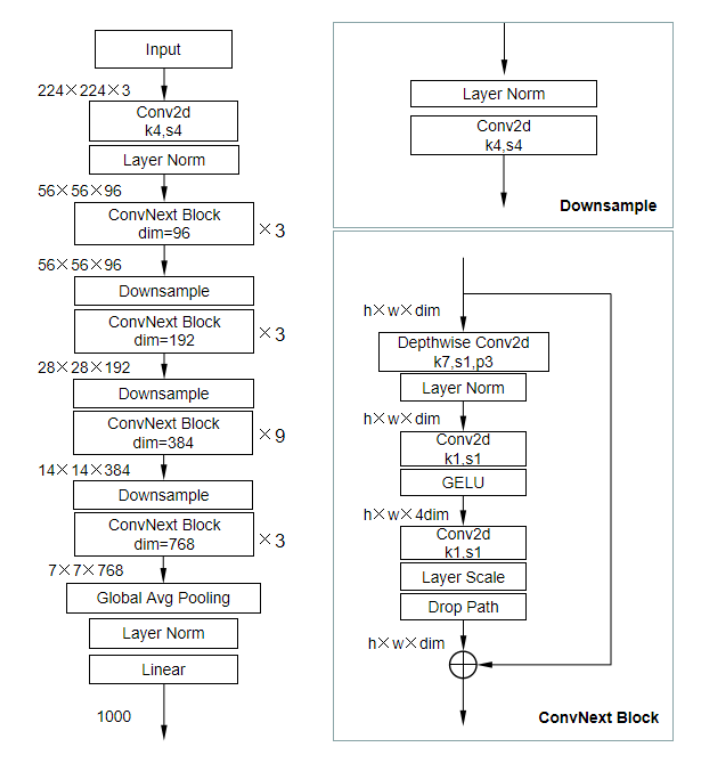
Figure 4. Architecture of